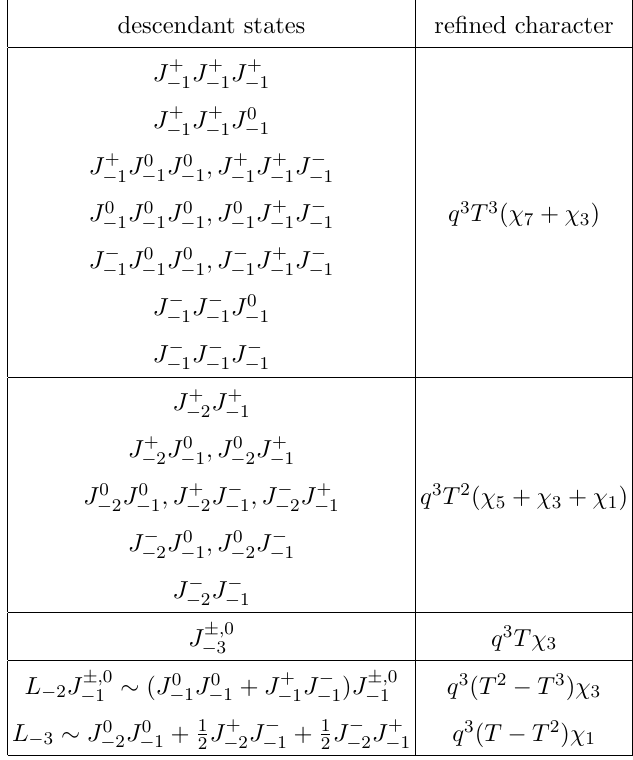
Table 1 . The descendant states of a generic vacuum module at level 3 and their contribution to the re(cid:12)ned character. The last two rows account for the relation among the Virasoro and a(cid:14)ne current generators. We subtract the states that have the higher powers in T and then replace it by the one that has lower powers in T